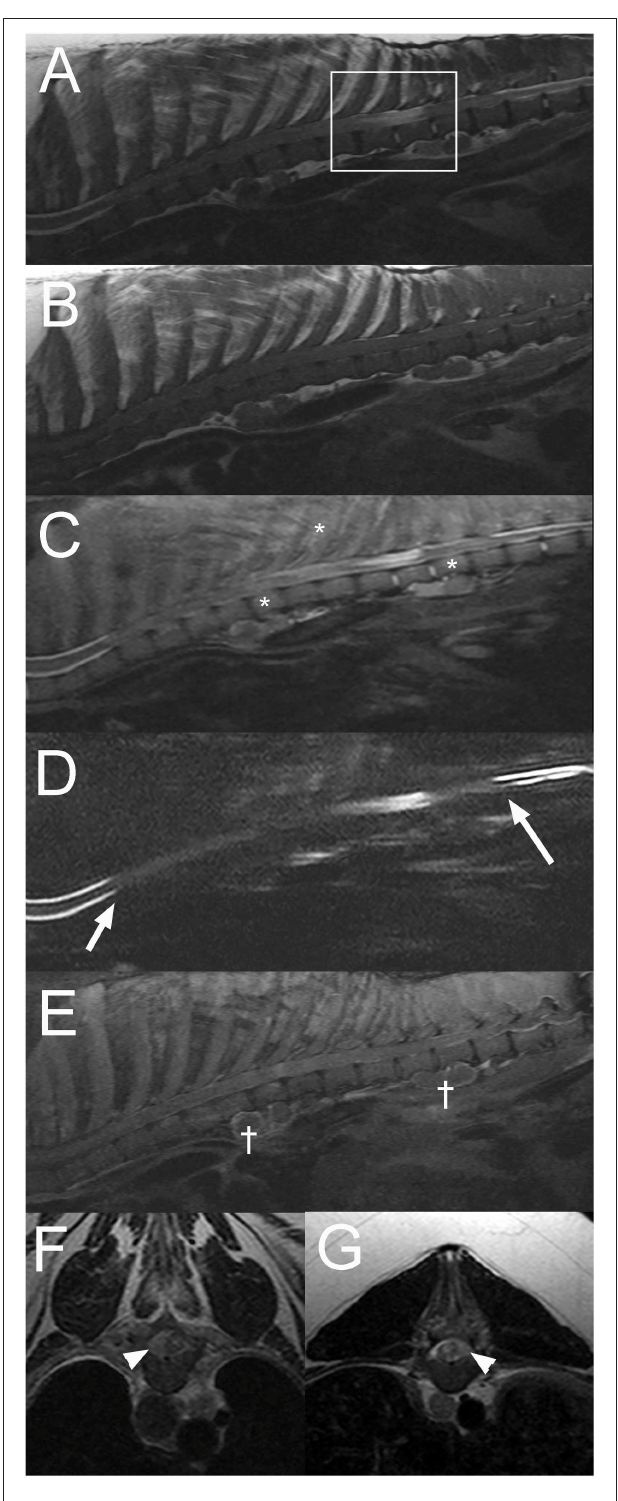
FIGURE 2 | Sagittal T2W (A) , T1W (B) , short tau inversion recovery (STIR) (C) , half-Fourier acquisition single-shot turbo spin-echo magnetic resonance imaging (HASTE) (D) , post contrast T1W fat saturated images (E) , and transverse T2W images at the level of T6-7 (F) , and T11-12 (G) intervertebral